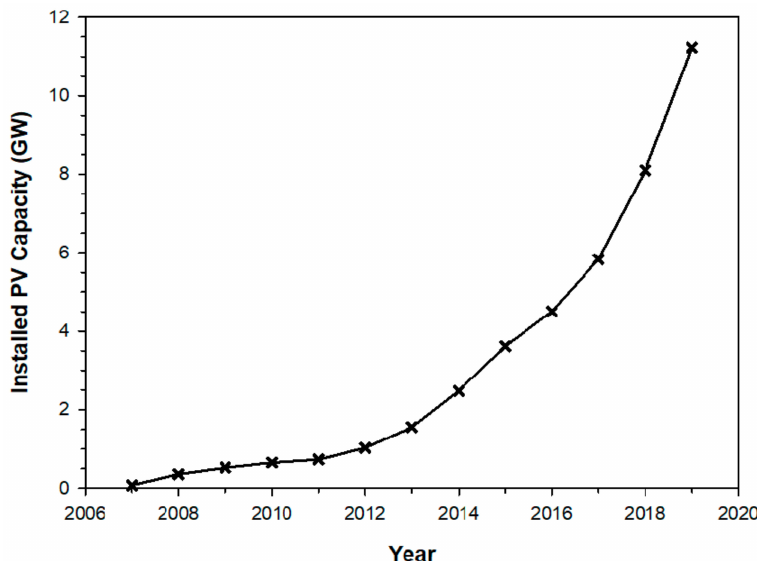
Figure 11. Annual capacity of photovoltaic system installed in Korea, based on the EPSIS